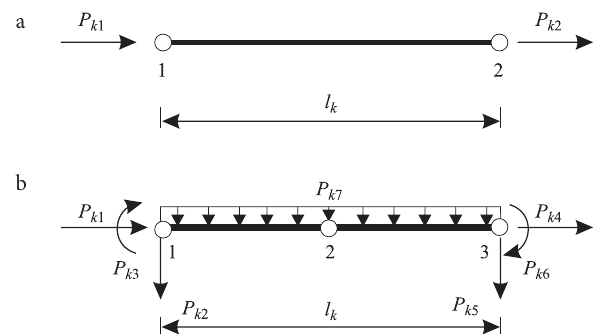
Fig. 2. Finite element reactions of